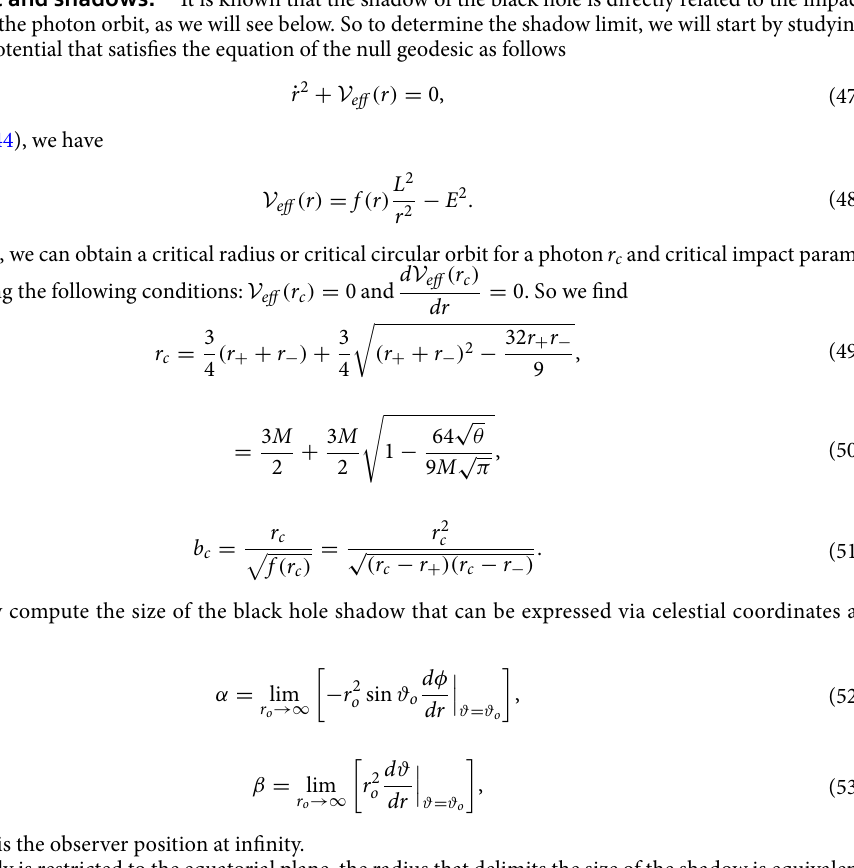
1 . We can clearly see the influence of = 0 (Schwarzschild case) to ( d ) (cid:31) 0.12 = =